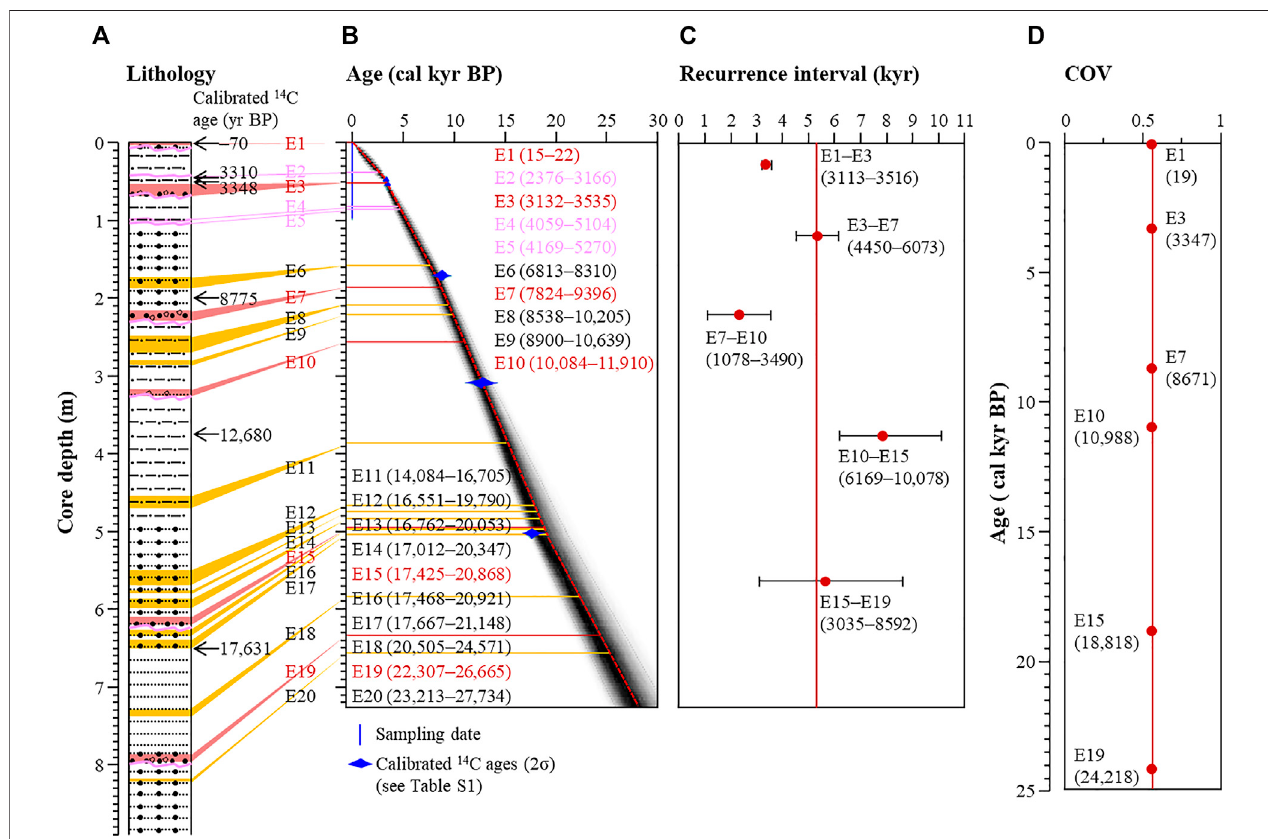
FIGURE9|(A) Lithology,calibrated 14 CagesandsedimentaryrecordofpastearthquakesfromtheY20Bcore.Redandyellowbarsindicatethehorizonsofmass- wastingdepositsandturbidite-likeseismites, respectively.Lithologicallegendsaresameas Figure2 . (B) Bayesianage – depthmodeloftheY20Bcore.Reddashedline indicates weighted mean age. The Bayesian ages (cal year BP) of earthquake events (E1 – E20) are given in parentheses. (C) Recurrence intervals of potential M s ≥ 8.0 earthquakes (E1, E3, E7, E10, E15 and E19). Red circles indicate weighted mean recurrence intervals, and red line indicates average recurrence interval (5,303 years). (D) Coef fi cientofvariation(COV)forpotential M s ≥ 8.0earthquakes.Redcirclesindicateweightedmeanagesofearthquakes,andredlineshowstheCOV value